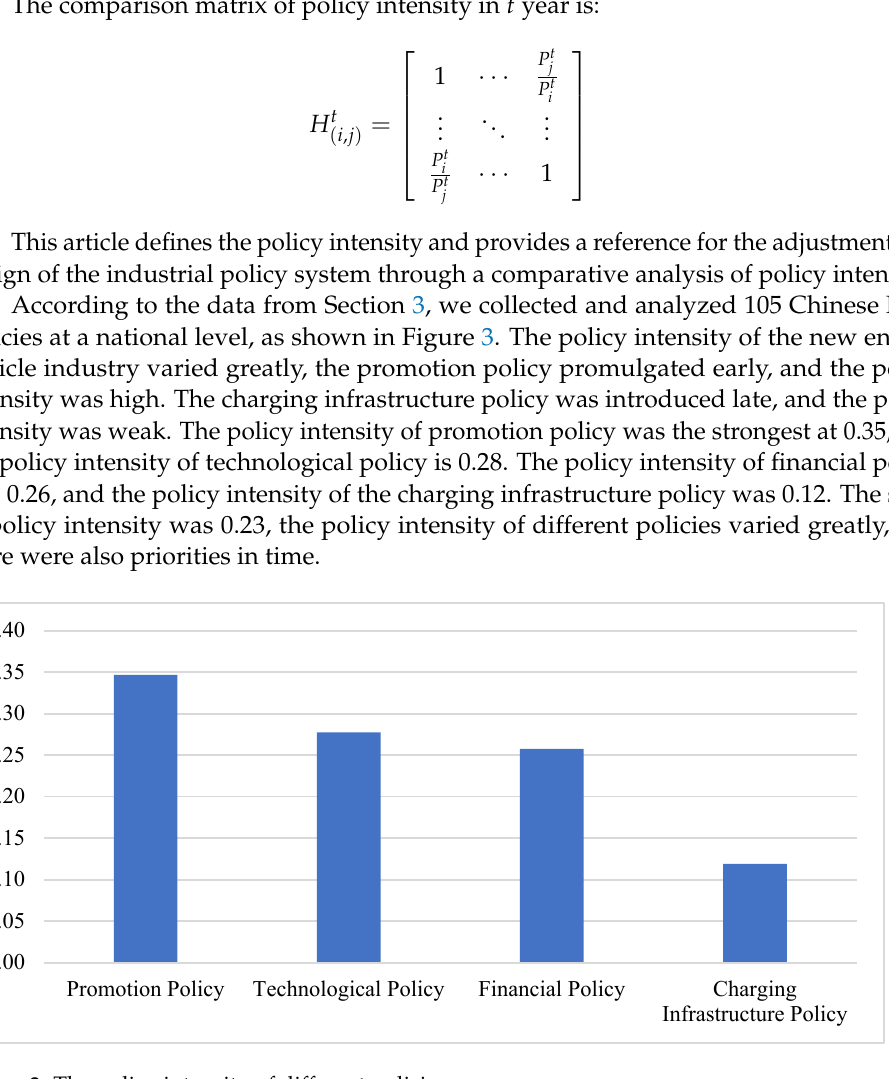
Figure 3. The policy intensity of different policies.